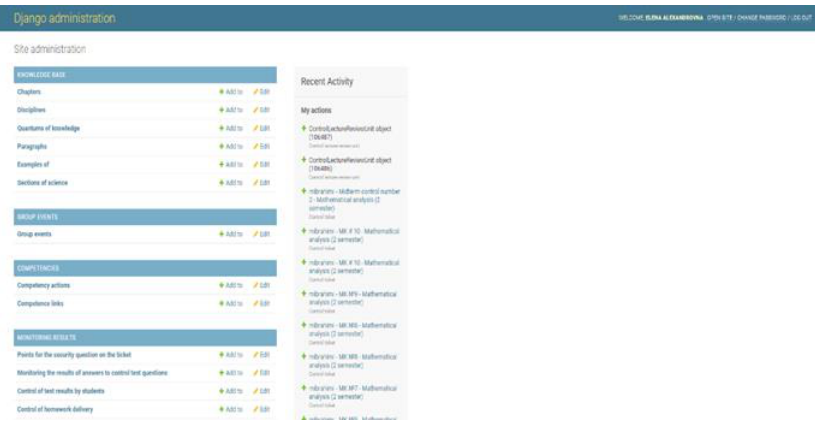
Fig. 1. The window of the «Teacher's Personal Account» subsystem in the Nomotex DLS.